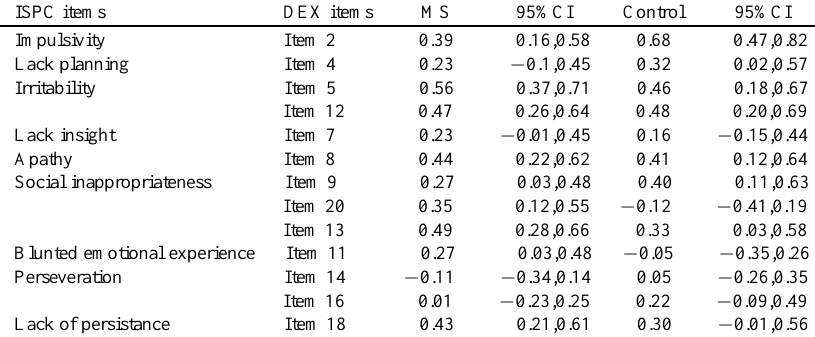
Table 5 Spearman correlations between selected corresponding ISPC (postmorbid scores) and DEXr